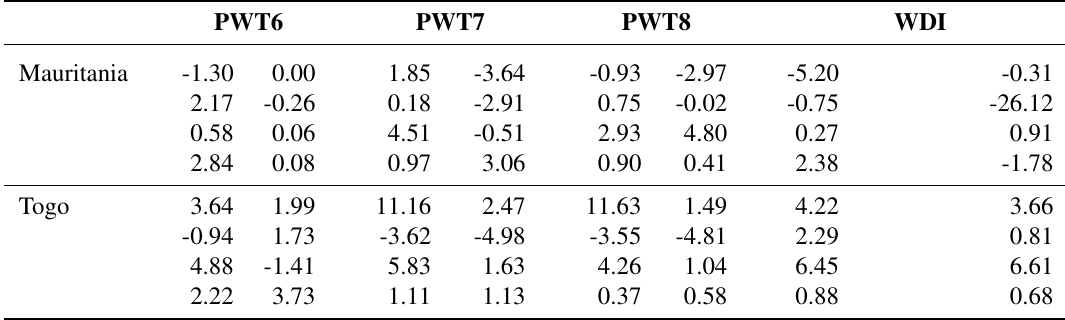
Table 12: Table 12